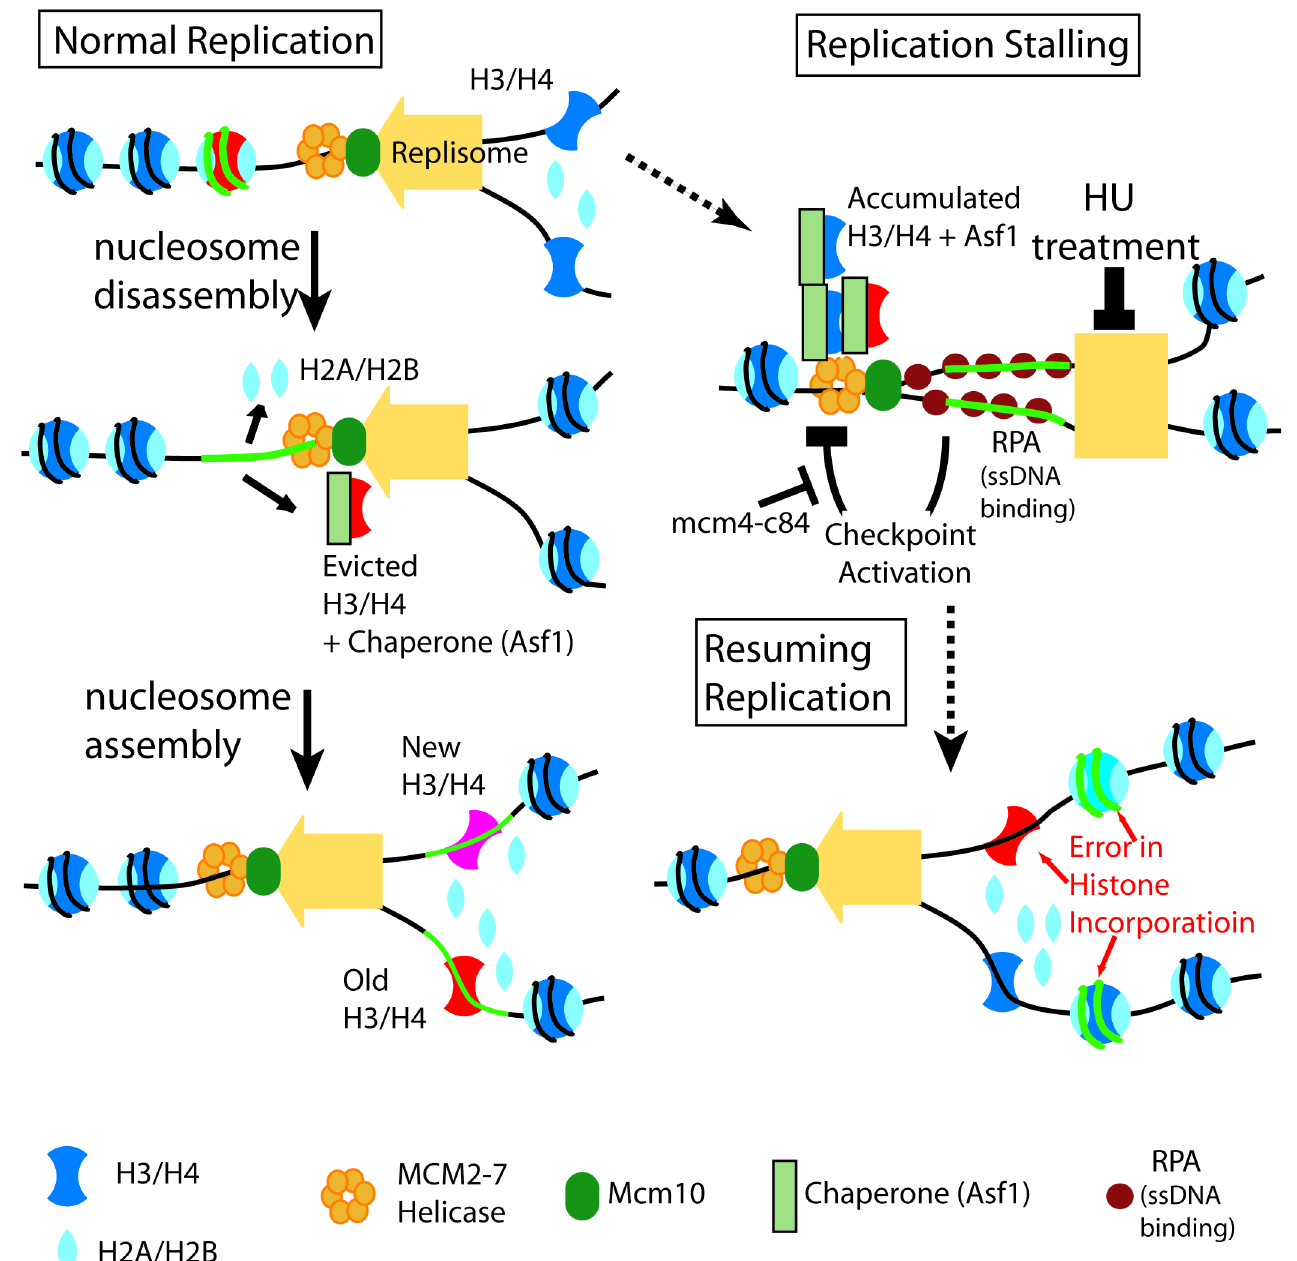
Fig 7. Replication stalling affectsRC nucleosome assembly. Left: normal RC nucleosome assembly. Individualnucleosomes are distinguished by colors. Accurate duplicationof chromatinis exemplified by the “red” nucleosomesmaintaining associationwith the “green”DNA segment after replication.Right: duringreplicationstalling(HU), helicasecontinuesunwindingDNA, accumulatingevicted parentalhistonesand forming ssDNA, which cause errors in parentalhistone recyclingafter replication resumes. Mutant such as mcm4-84c , that causes excessiveformation of ssDNA, aggravates the defect in